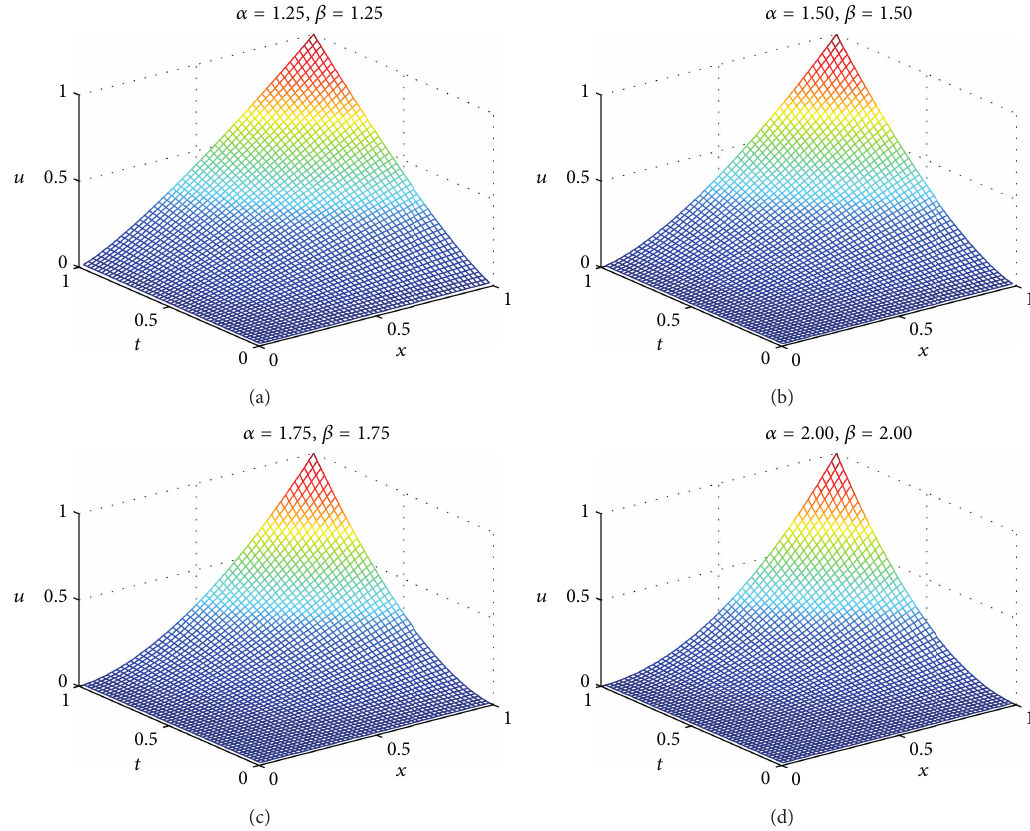
Figure 2: Numerical results of Example 24 for different values of 𝛼 and 𝛽